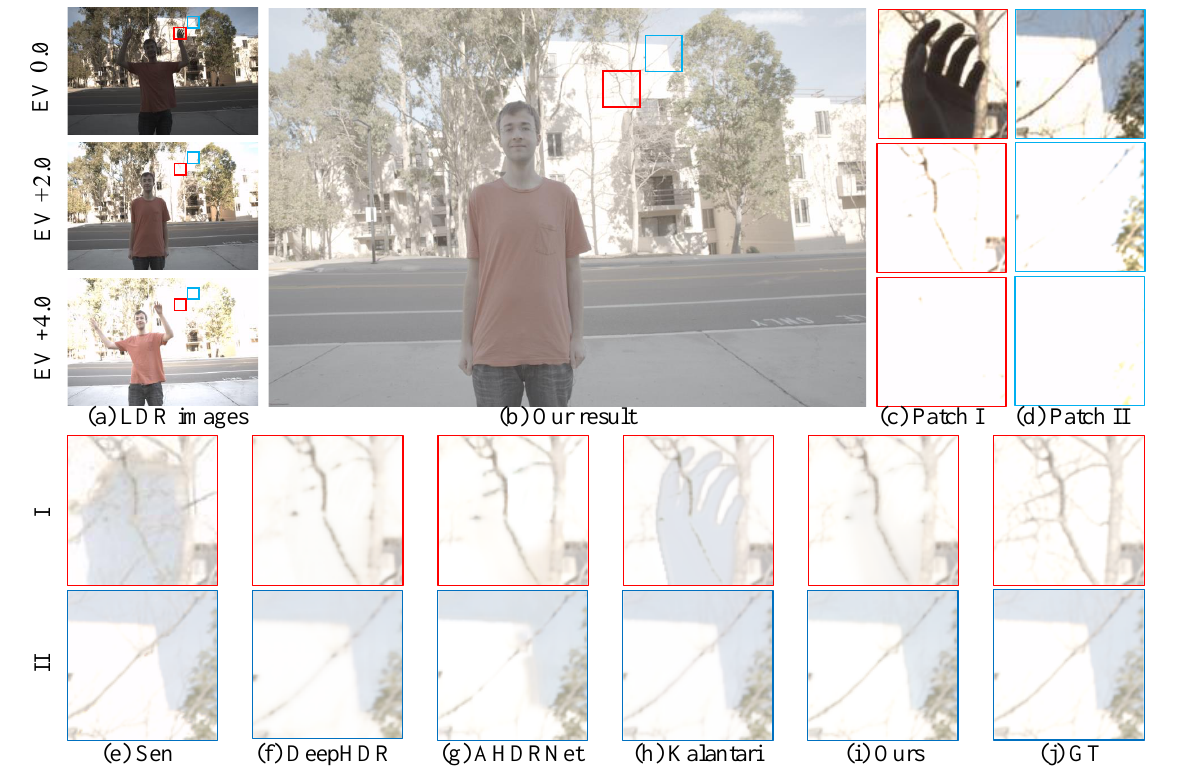
Figure 3. Comparison against the state-of-the-art methods on Kalantari’s dataset [18]. In the upper half of the figure, the left column ( a ) shows the LDR images with three exposure levels, ( b ) is our tone-mapped HDR result, and the last two columns ( c , d ) show two zoomed-in LDR regions (I and II) marked in the HDR image. In the lower half, we compare the zoomed-in HDR regions (I and II) of our results ( i ) with other results [5,15,16,18] ( e – h ), and GT represents the zoomed-in ground truth ( j